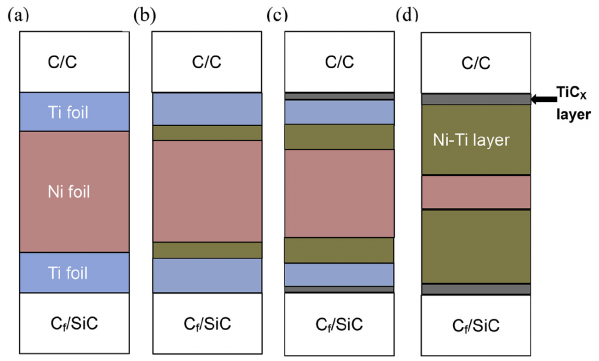
Figure 4: The formation model of the C/C-C f /SiC composite joint.